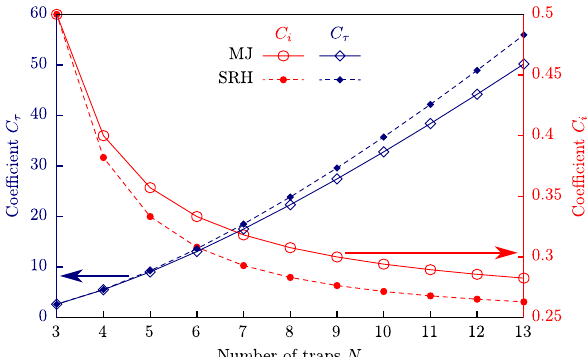
Figure 4. The C i and C τ coefficients values.